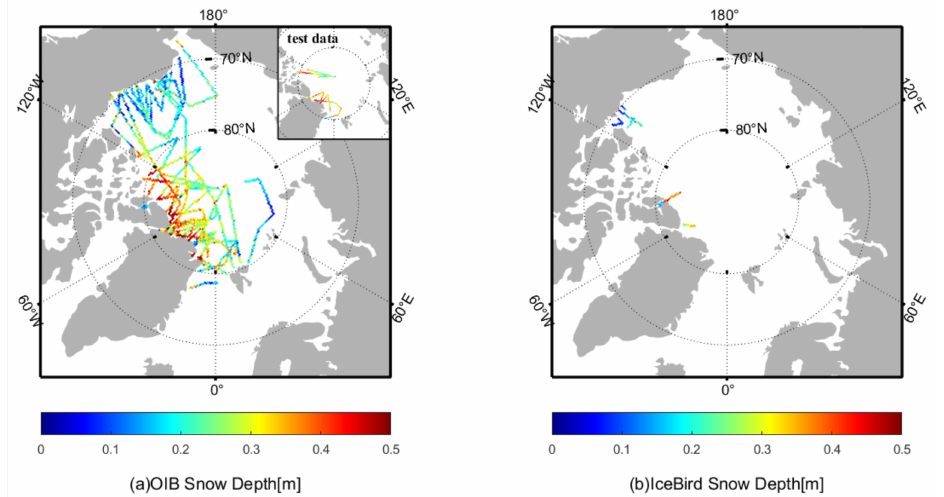
Figure 1. Airborne snow depth map: ( a ) Operation IceBridge (OIB) from March 2013 to April 2019, the sub-figure on the top right shows the OIB data used to test model and other snow depth products. ( b ) IceBird in April 2019.